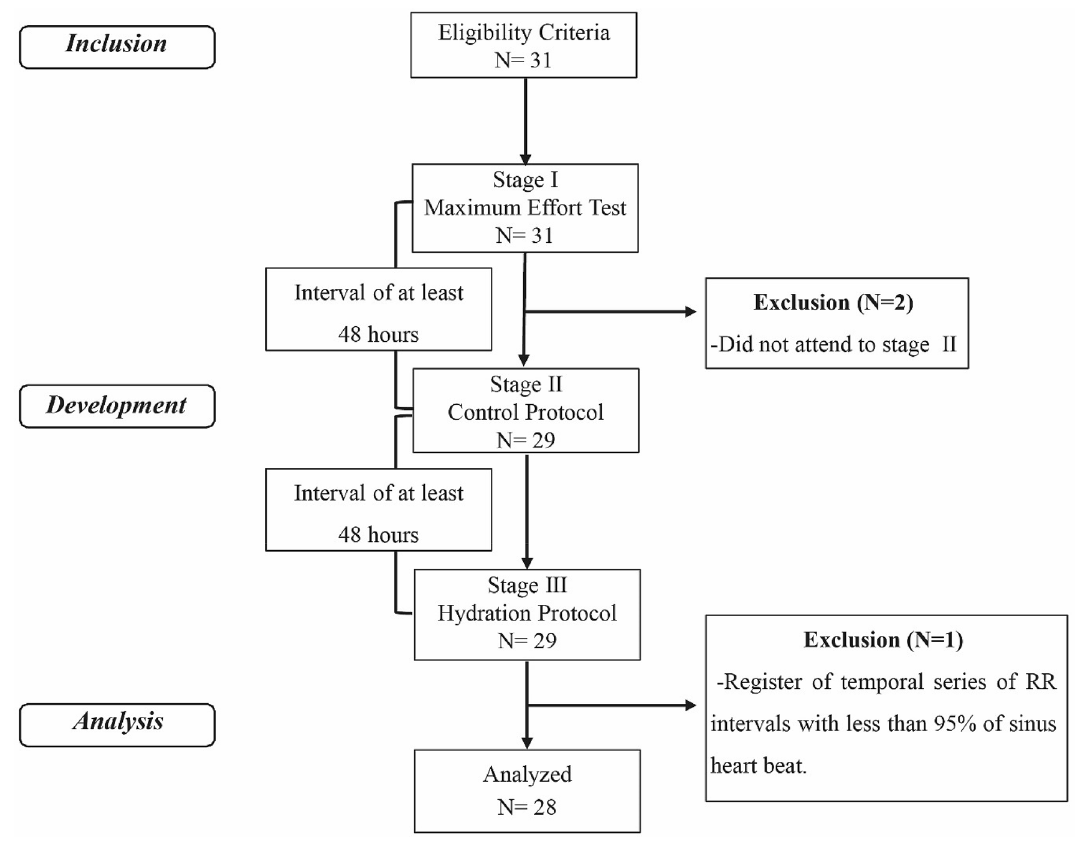
Figure 1. Protocol